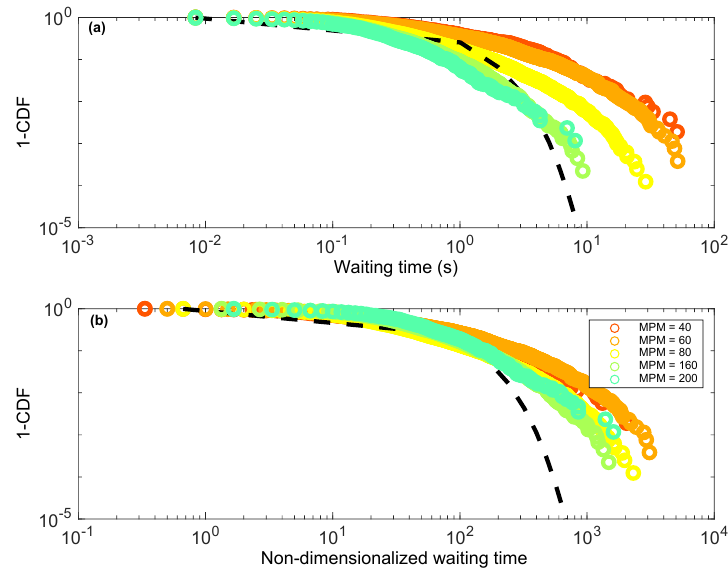
Figure 6. Complementary cumulative probability plots of waiting times between emigration events; (a) data for all experiments and (b) the same data normalized by the driving frequency of each respective experiment. Expectation from an exponential distribution is shown for comparison with dashed line. Legend as in Fig.